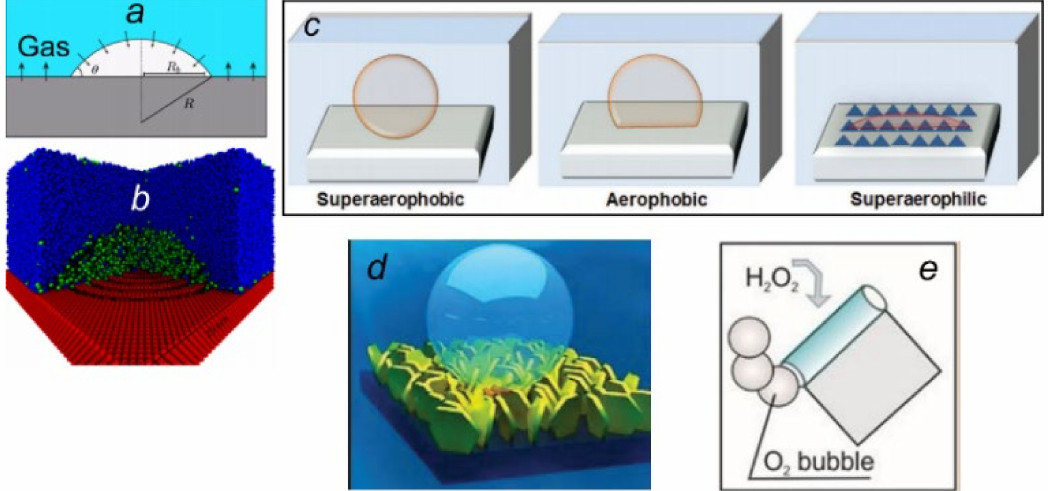
Figure 3. Schematic illustration of the formation of a gas bubble on a ( a ) flat and ( b ) rough surface. Reproduced with permission from Ref. [89], Copyright 2020, American Chemical Society. ( c ) Schemes for gas bubble formation on superaero- phobic, aerophobic and superaerophilic surfaces. Reproduced with permission from Ref. [84], Copyright 2017, WILEY-VCH Verlag GmbH & Co. KGaA, Weinheim. Examples of catalysts with superaerophobic properties: ( d ) An array of 2D crystals. Reproduced with permission from Ref. [90], Copyright 2019, Elsevier. ( e ) Microtube faces. Reproduced with permission from Ref. [39], Copyright 2019, Wiley-VCH Verlag GmbH & Co. KGaA,